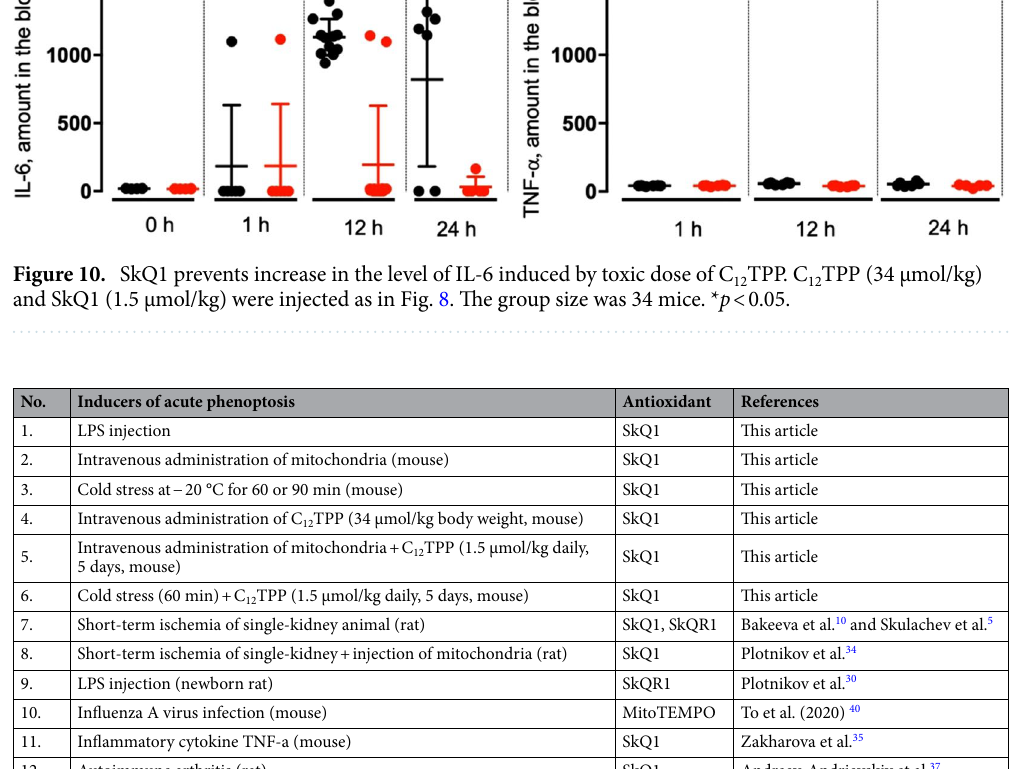
Table 1. Various cases of acute phenoptosis prevented by mitochondria-targeted antioxidants.